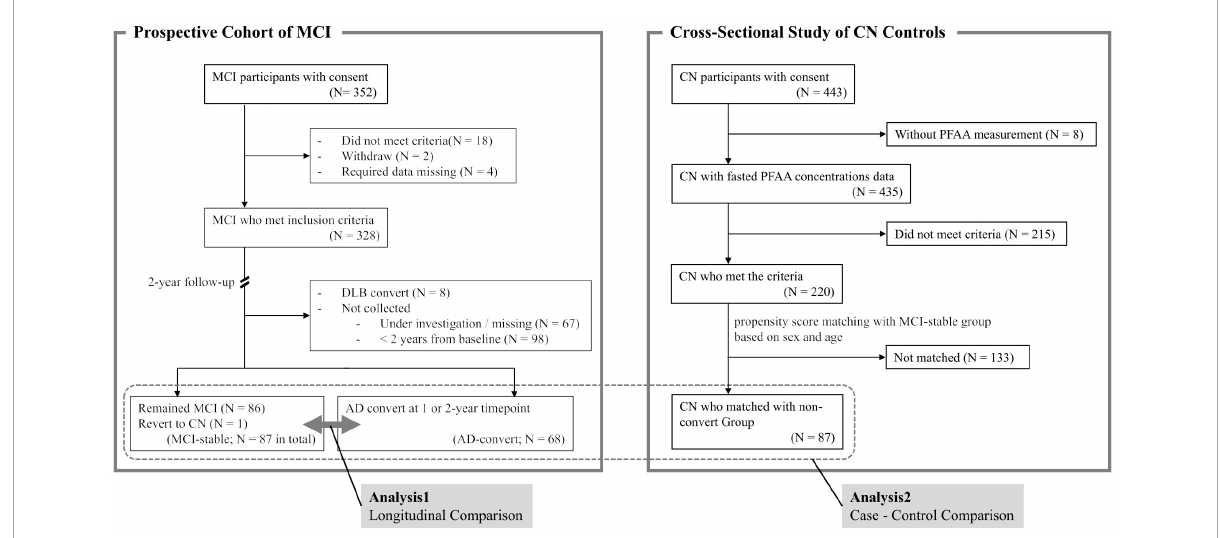
FIGURE1 Summary of study design. MCI, mild cognitive impairment; AD, Alzheimer’s disease; DLB, dementia with Lewy bodies; CN, cognitively normal; PFAA, plasma free amino